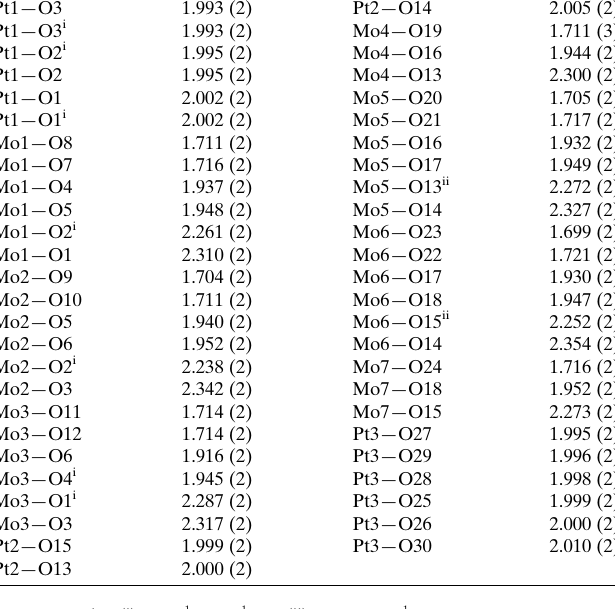
Table 1 Selected bond lengths (A˚ ).